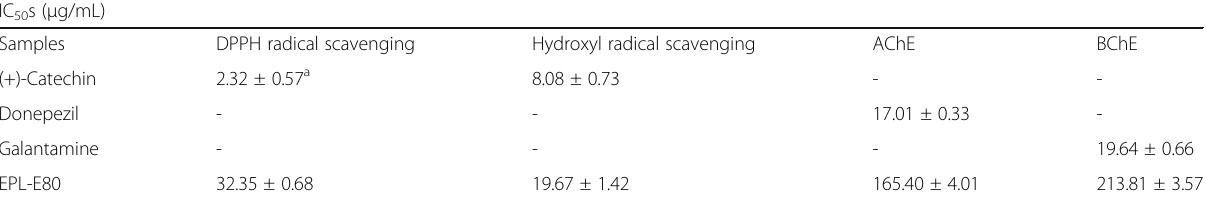
Table 1 IC 50 values of EPL-M80 and standards in radicals scavenging and enzymes inhibitory activity assays